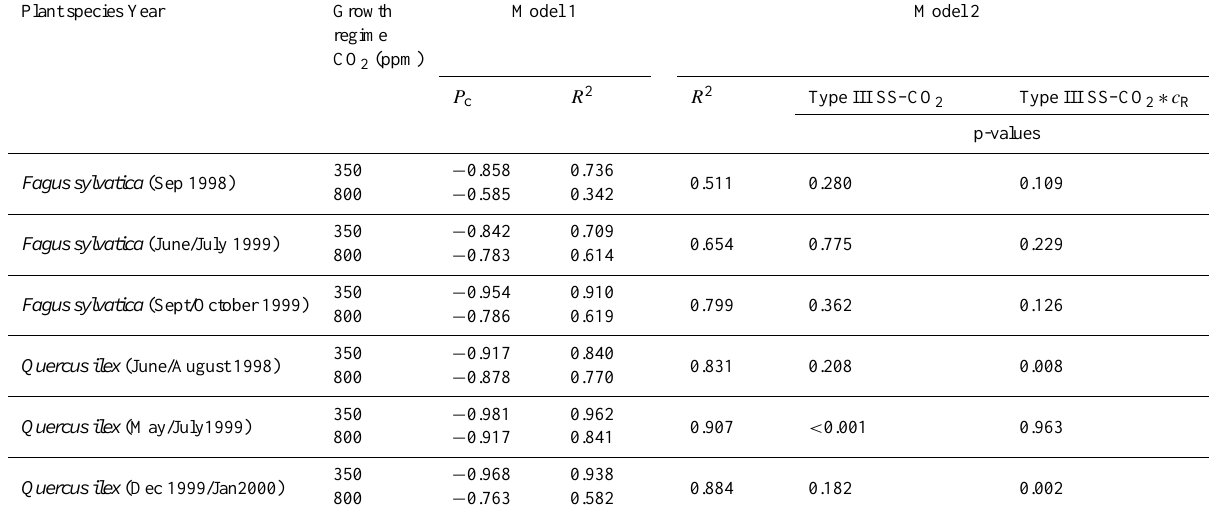
Table 3. Correlation (Pearson’s coefficient, P c ) and regression analysis ( R 2 ; see Fig. 1) according to model 1 regarding the correlation between the initial COS concentration in the reference cuvette ( c R ) and the exchange flux (SAS Version 9.1). Regression analysis ( R 2 ; see Fig. 1) according to model 2 regarding the correlation between the initial COS concentration in the reference cuvette ( c R ) and the exchange flux. Model 2 describes the results taking into account the growth regime (SAS Version